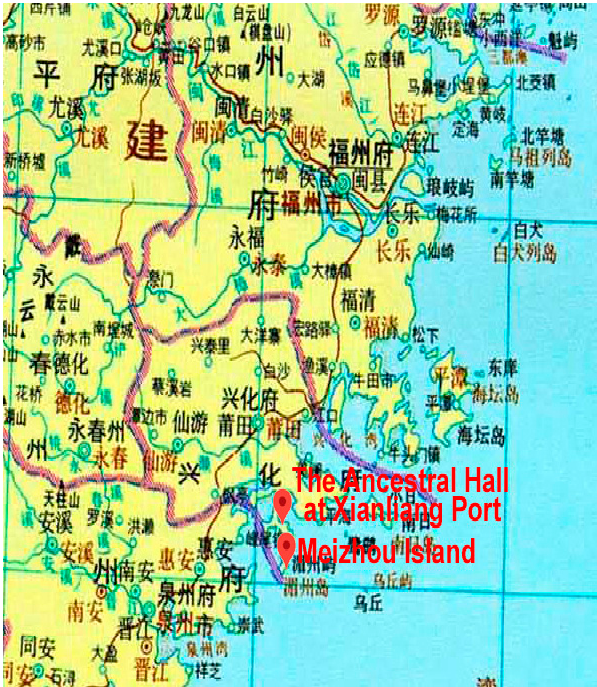
Figure 1. (Tan 1996) A Map of the Putian area during the Qing dynasty (1820). The locations of the Ancestral Hall at Xianliang port and Meizhou island as marked. Source: “The map of Fujian province in Qing dynasty” in Tan Qixiang ed. Zhongguo lishi ditu ji: http: // www.guoxue123.com / other / map / pic / 16 /